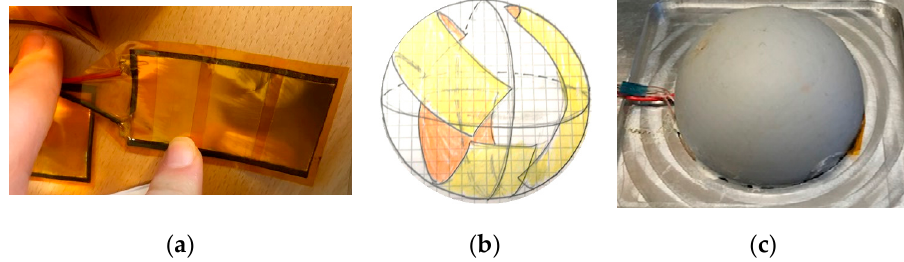
Figure 7. Sensing system: ( a ) at style dynamic pressure sensor; ( b ) Pressure sensor distribution inside the mold; ( c ) Open mold with rubber sample and pressure sensor.